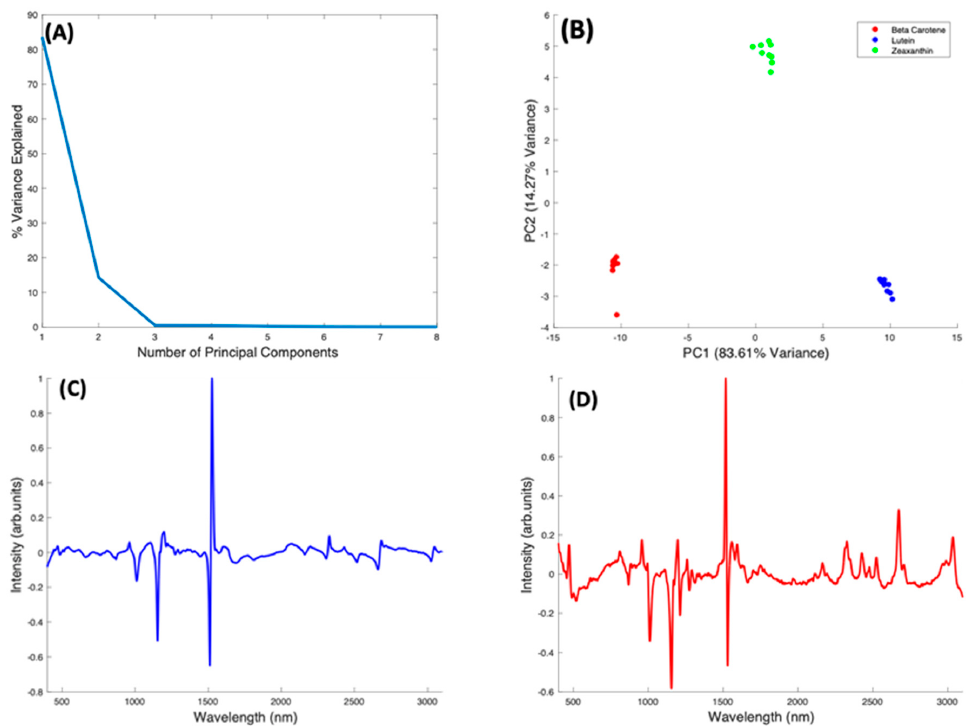
Figure 8. PCA of Beta Carotene, Lutein, and Zeaxanthin. ( A ): Explained percentage variance as a function of number of Principal Components. ( B ): Scatter plot scores for the first 2 principal components. ( C ): Plot of PC1 loading. ( D ): Plot of PC2 loading.